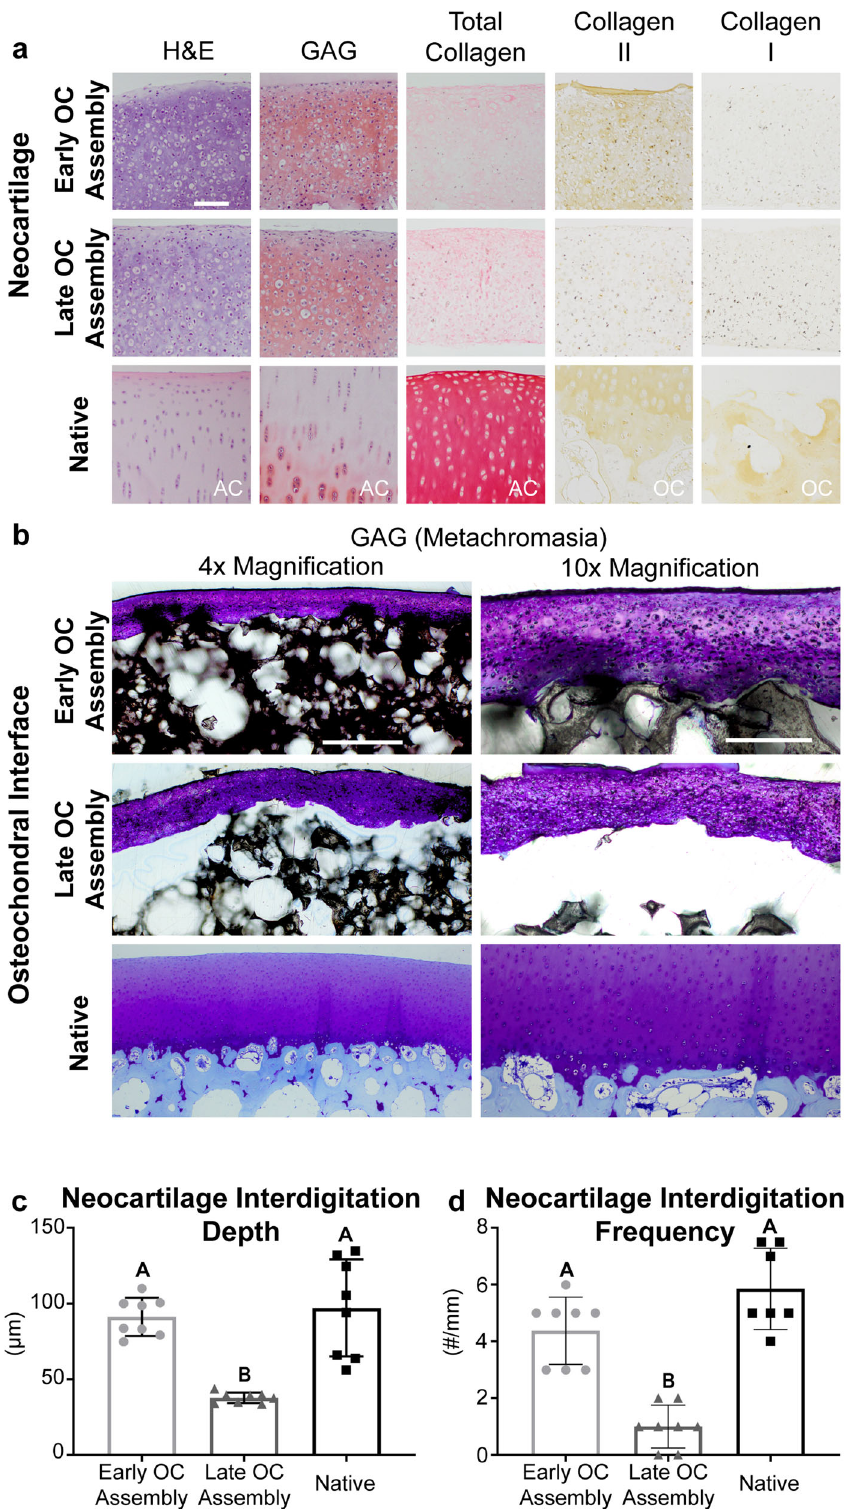
the staining pattern in native juvenile sheep articular cartilage. Neocartilage of the Late OC Assembly group was stained homogeneously throughout the section with comparable intensity to the Early OC Assembly group. Both groups stained less intensely than native articular cartilage. No mineralization